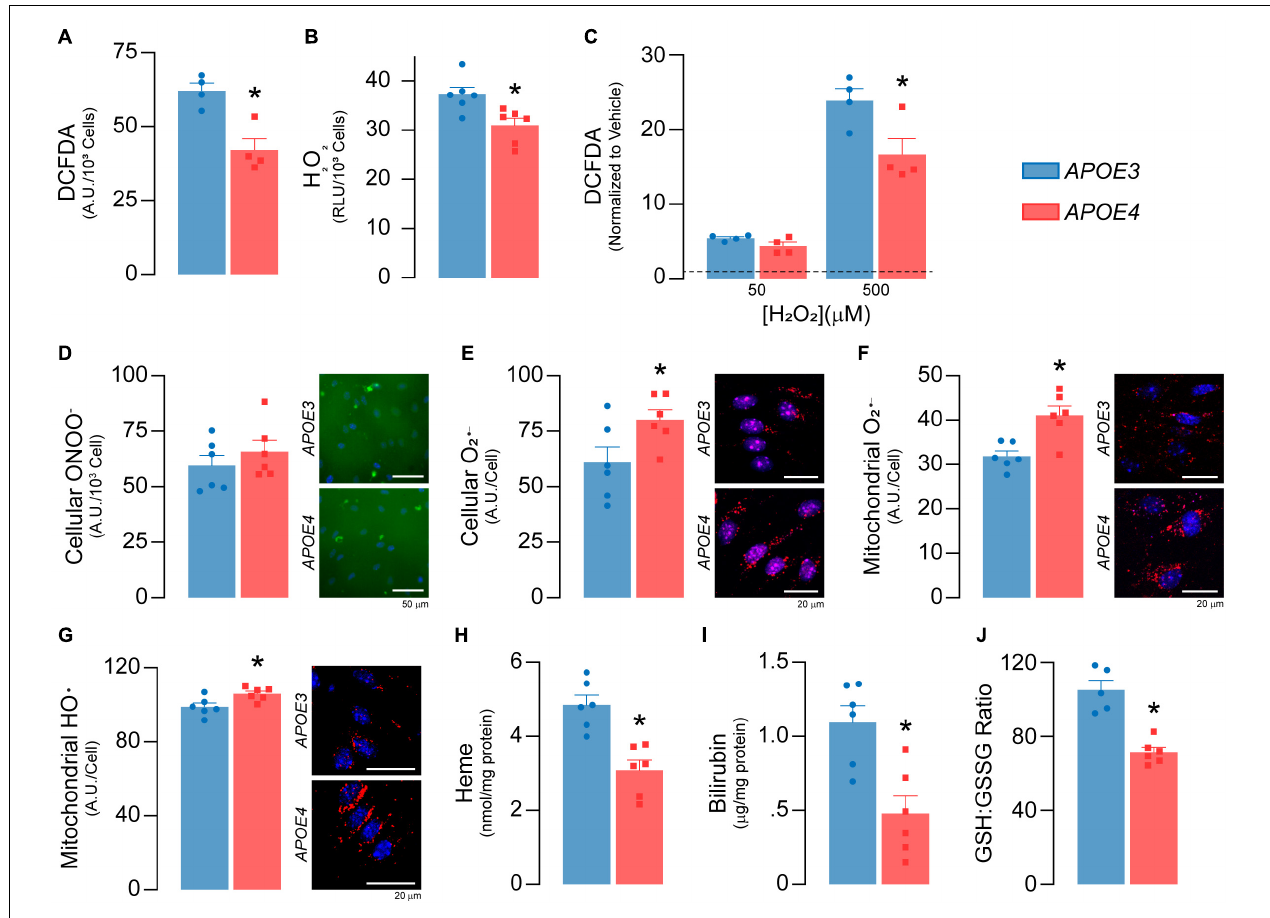
FIGURE 5 | APOE genotype modulates reactive oxygen species and antioxidant levels. (A) Total reactive oxygen species (ROS) levels were measured with 2 (cid:48) ,7 (cid:48) -dichlorofluorescein diacetate (DCFDA; n = 4). DCFDA diffuses into the cell where it is deacetylated to a non-fluorescent compound by cellular esterases. Reactive oxygen species then oxidize the deacetylated DCFDA to form 2 (cid:48) , 7 (cid:48) -dichlorofluorescein, which fluoresces green. APOE4 brain endothelial cells exhibit lower total cellular ROS as evidenced by ∼ 32% lower DCFDA fluorescence. Of the different types of ROS, H 2 O 2 is the most abundant and accounts for the majority of the DCFDA signal and (B) specific levels of H 2 O 2 are lower in APOE4 brain endothelial cells. After the addition of exogenous H 2 O 2 , (C) levels of total reactive oxygen species (DCFDA) are still higher with APOE3 ( n = 4), suggesting an upregulation of pathways to limit H 2 O 2 levels in APOE4 brain endothelial cells, such as peroxisome or other enzymatic activity. For other ROS, while there are (D) no changes in peroxynitrite levels with APOE4 , (E) there are ∼ 31% higher cellular O 2 − levels. These data are consistent with the idea that higher mitochondrial metabolism can result in the accumulation of O 2 − . Indeed, specifically for mitochondrial ROS, there are (F) ∼ 29% higher O 2 − (MitoSOX Red O 2 − Indicator which accumulates in mitochondria and is oxidized by O 2 − ) and (G) ∼ 7% higher hydroxyl radical (OH580 probe which is oxidized by hydroxyl radicals) levels in APOE4 brain endothelial cells. The effects and levels of reactive oxygen species are in part regulated by antioxidant systems. Heme is an essential iron-containing compound with pleiotropic functions from respiration, oxygen transport and xenobiotic modification to modulation of reactive oxygen species levels. Heme is produced from glycine and succinyl CoA in a series of reactions that starts in the mitochondria, continues in the cytoplasm, and is then completed in the mitochondria. Heme can be degraded into bilirubin, which is an antioxidant and anti-inflammatory molecule. APOE4 brain endothelial cells have lower levels of (H) heme and (I) bilirubin, and (J) a lower ratio of GSH:GSSG (indicating more oxidative stress; APOE3 n = 5, APOE4 n = 6). Data is expressed as mean ± S.E.M. * p < 0.05 by Student’s t -test with n = 6 (unless otherwise specified